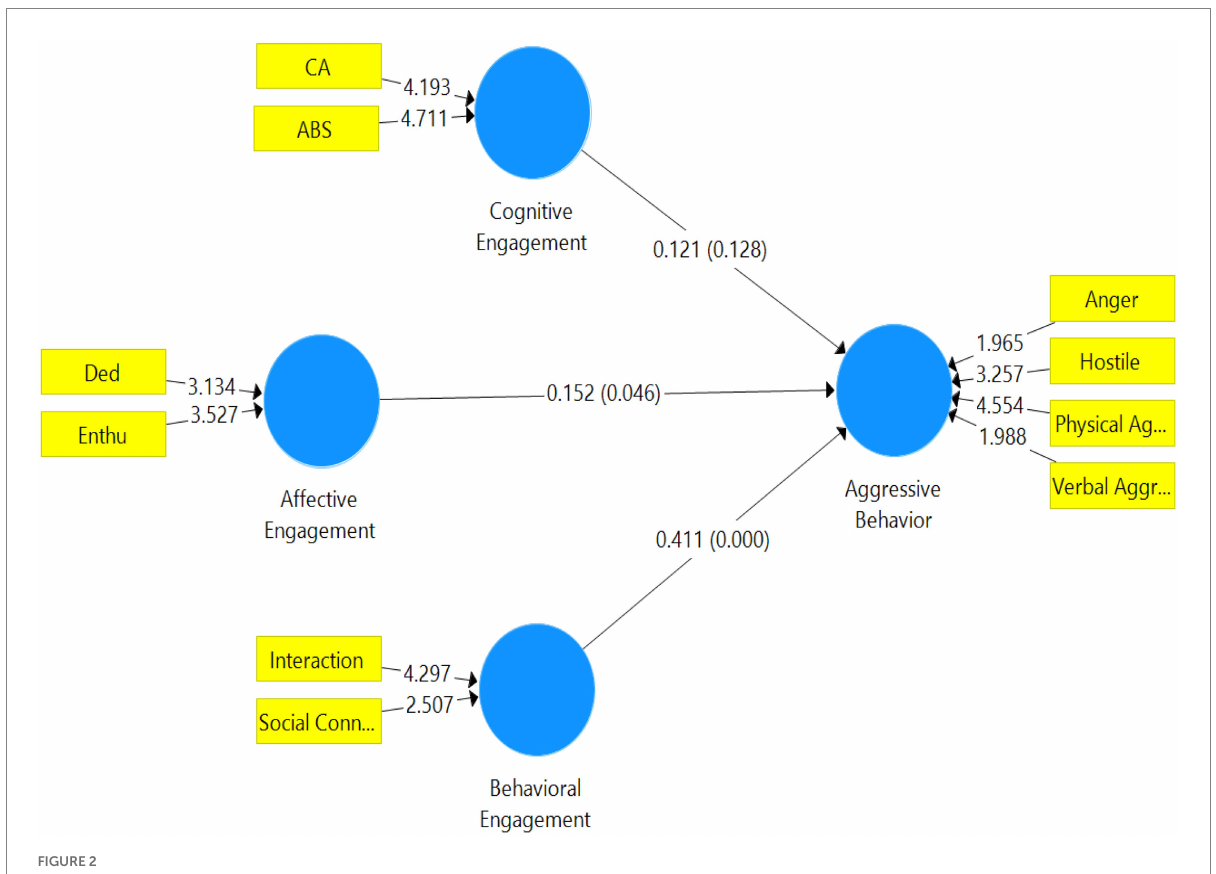
FIGURE 2 A conceptual model with hypothesis